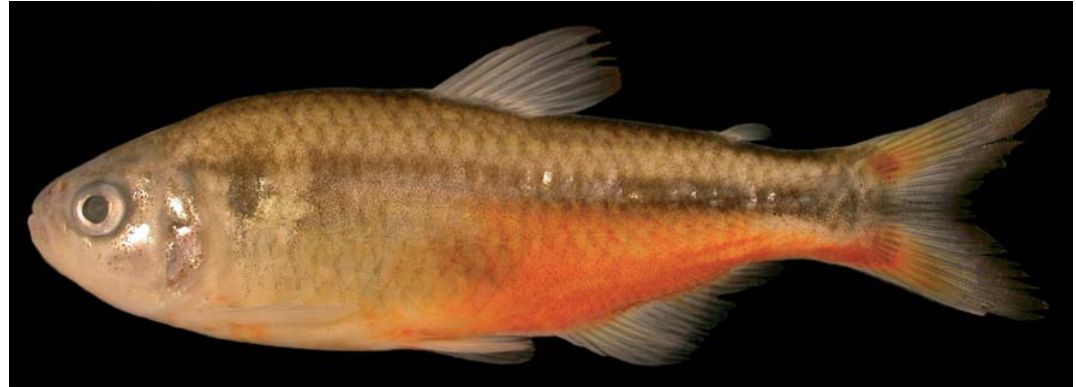
Fig. 1. Hyphessobrycon vinaceus , MCP 40916, holotype, male, 56.5 mm SL; Brazil, Minas Gerais, São João do Paraíso, rio São João, tributary of upper rio